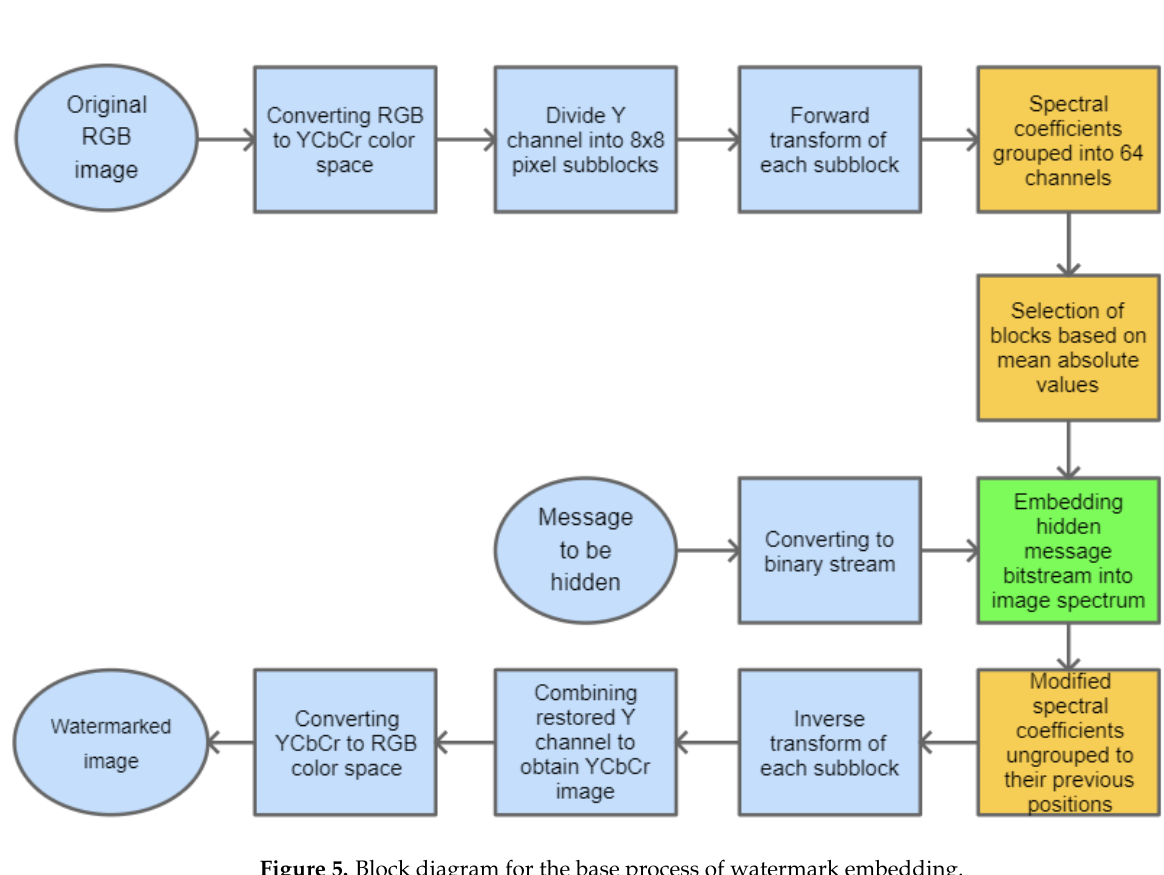
Figure 5. Block diagram for the base process of watermark